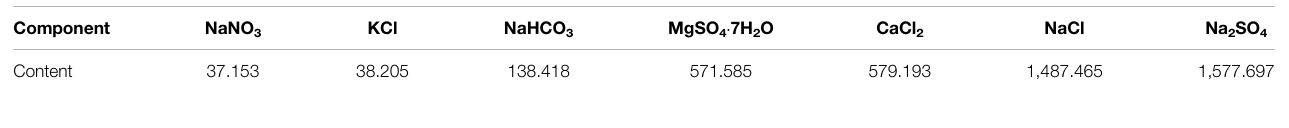
TABLE 2 | Simulated chemical components of groundwater in Beishan area (mg/L).